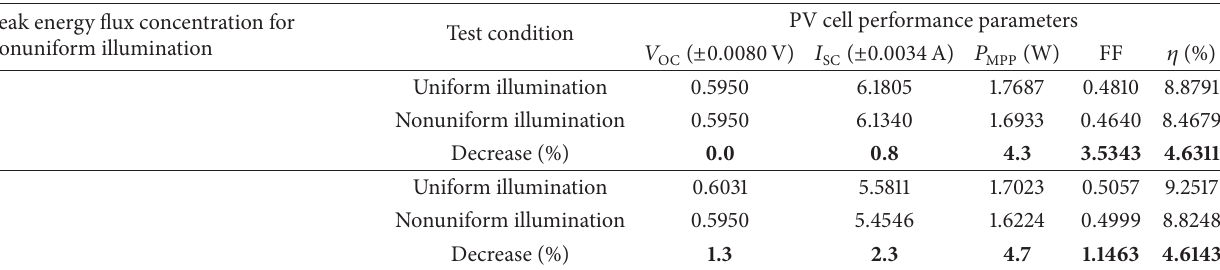
Table 8: Variation of PV cell performance parameters with energy illumination profiles for 3 and 6 concentrations of peak energy intensity. Peak energy flux concentration